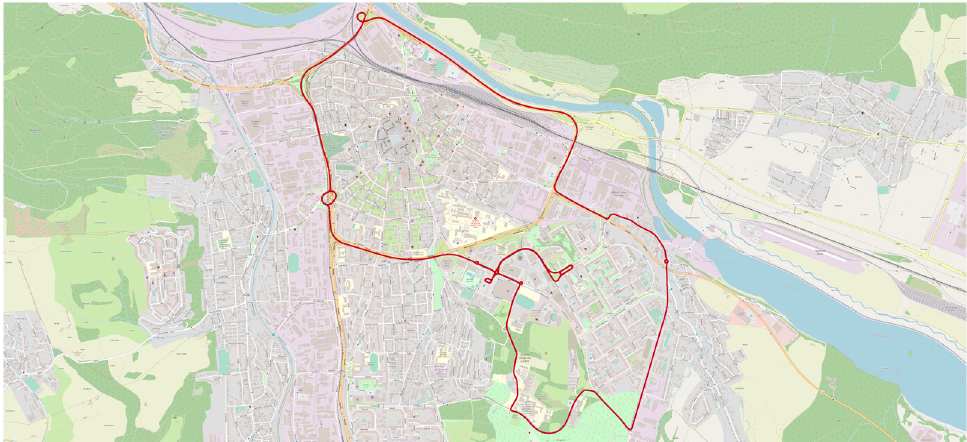
Figure 7. Test route TR1 in city of Žilina on OpenStreetMap (OSM) map layer.